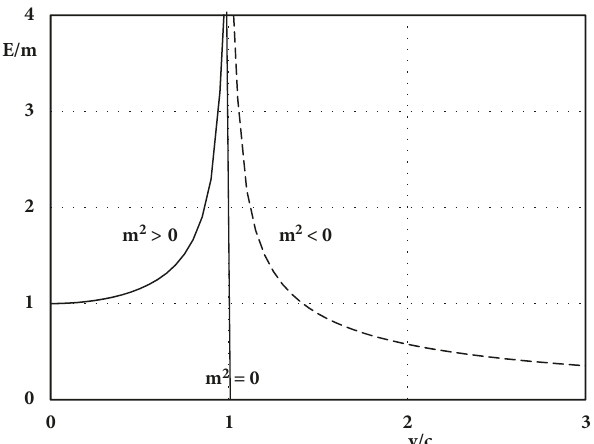
Figure 1: 𝐸/|𝑚| versus V /𝑐 for 𝑚 2 > 0, 𝑚 2 < 0 and 𝑚 2 = 0